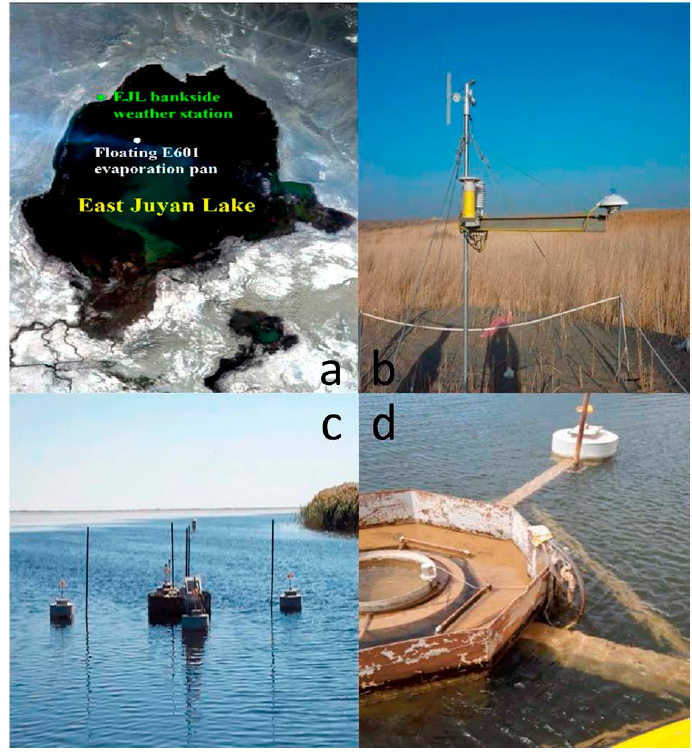
Figure 2. Image of East Juyan Lake (EJL) ( a ); EJL bankside weather station ( b ) and floating E601 evaporation pan ( c , d ).